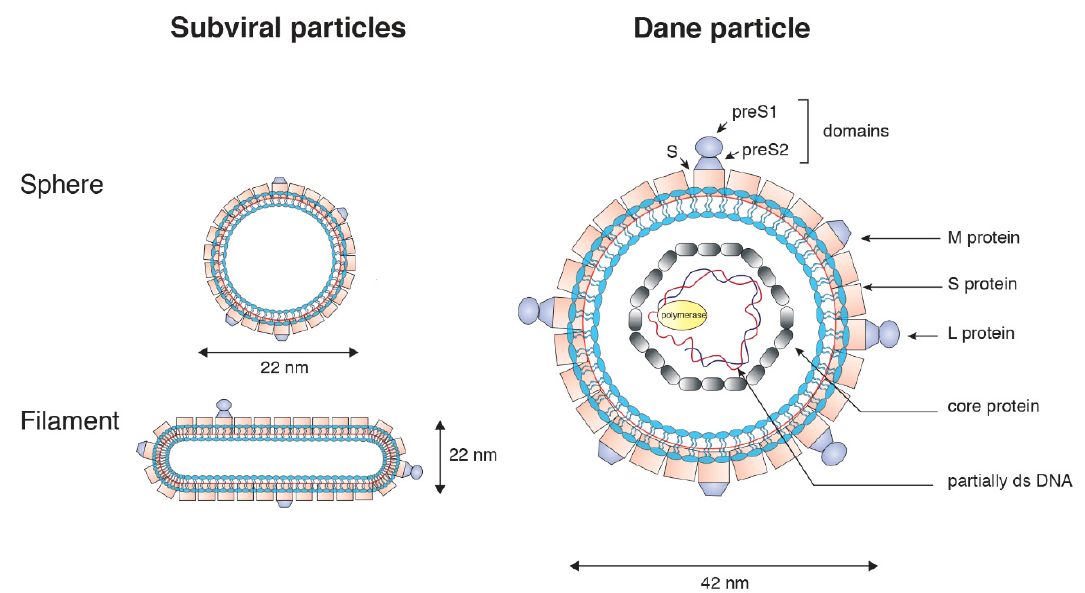
Figure 1. Schematic diagram of hepatitis B virus (HBV) particles.